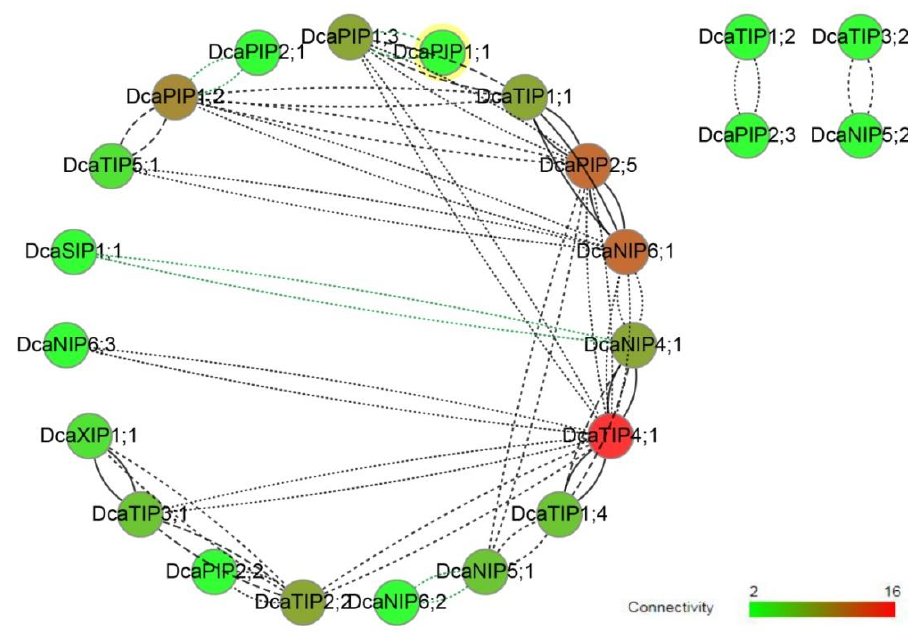
Figure 3. Co-expression network of DcaAQP genes constructed based on the RNA-seq results in this study. The network was obtained with CoExpNetViz (Tzfadia et al. 2016) and visualized by Cytoscape V. 3.1.0 (Shannon et al. 2003). Black and green lines denote positive correlation and negative correlation, respectively. Correlation from weak to strong represents dotted line to solid line. Connectivity from weak to strong represents from green to red.